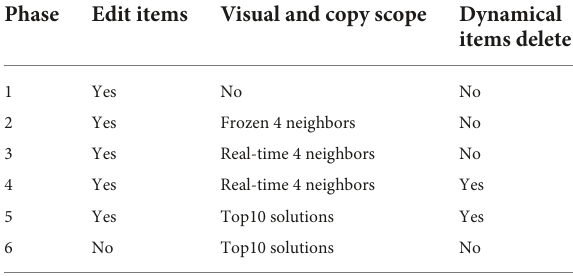
TABLE 1 Phases of the experiment and basic properties of each